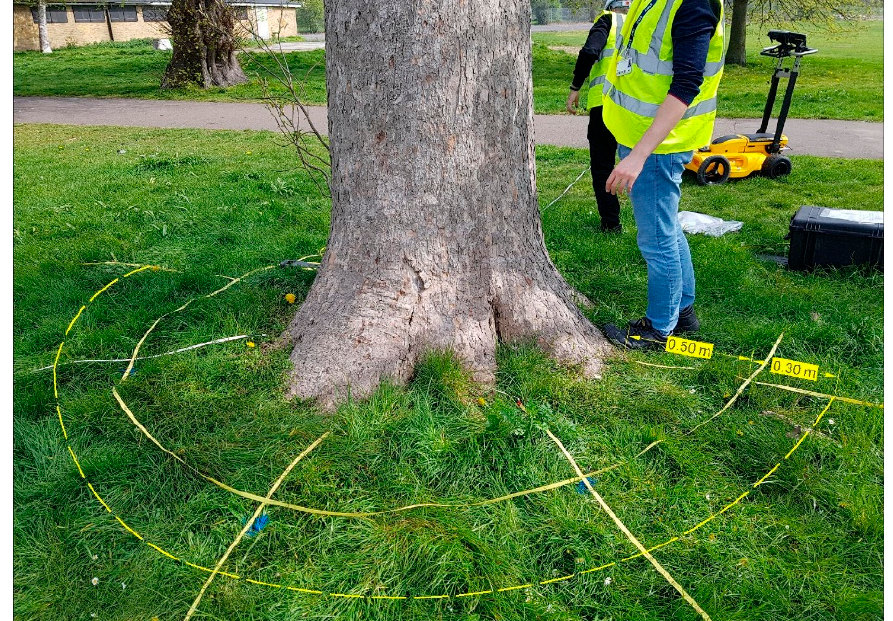
Figure 2. Detail of the survey setup.